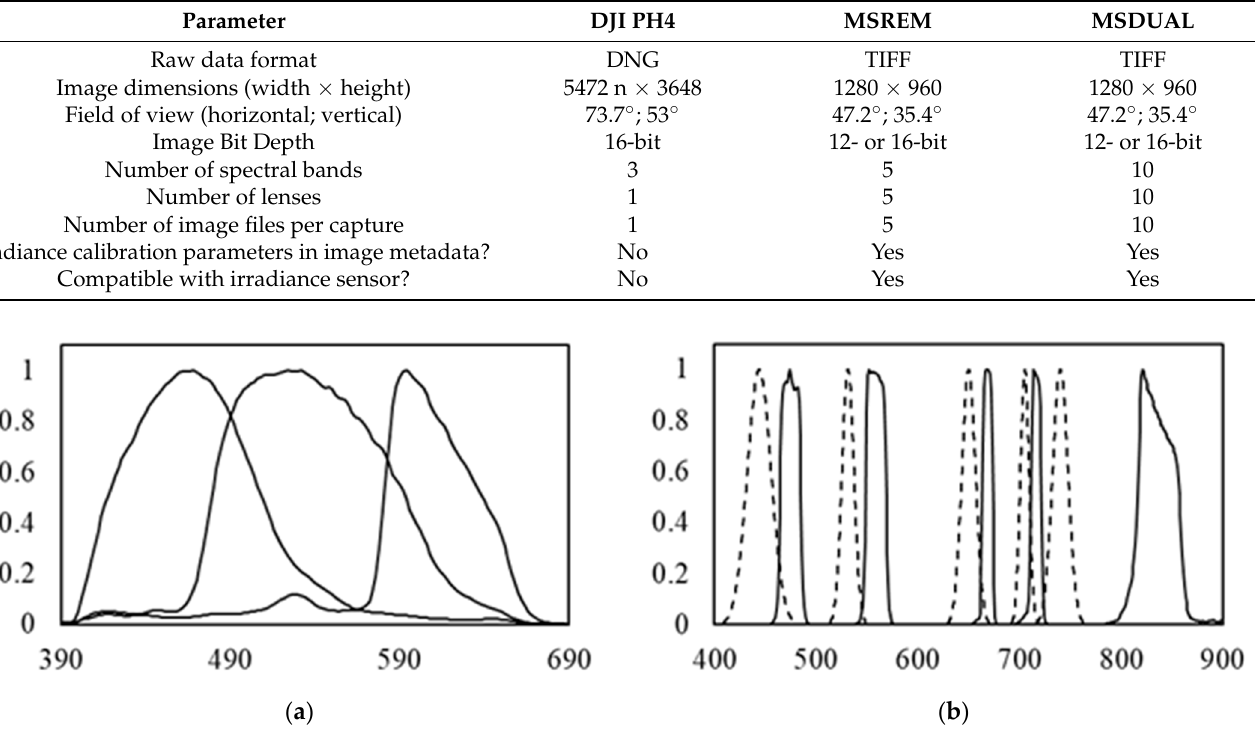
Figure 2. Spectral response curves showing the normalised response as a function of wavelength [27] for ( a ) DJI PH4pro and ( b ) MS-DUAL, consisting of MS-REM (solid lines) and MS-BLUE (striped lines). Table 1. Summary of three different camera systems used in this study.